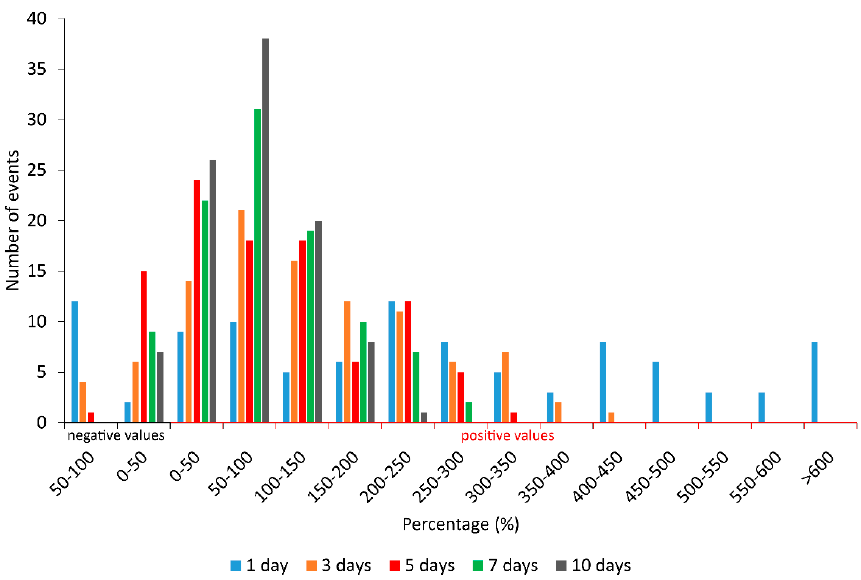
Figure 2. Percentage moisture supply from the Mediterranean Sea relating to each extreme event (PFLEX-%) on an annual scale for the 100 events analysed and all ranked durations: Blue bars represent number of events with 1-day duration; orange bars represent 3-days duration; red bars represent 5-days duration; green bars represent 7-days duration; and grey bars represent 10-days duration.